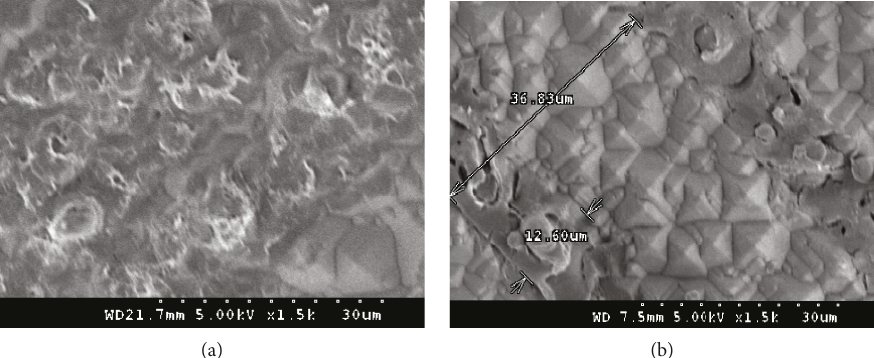
Figure 7: FESEM surface morphology images of backside surfaces of SPMSCs with various laser line pitches of (a) 10 and (b) 40 μ m.